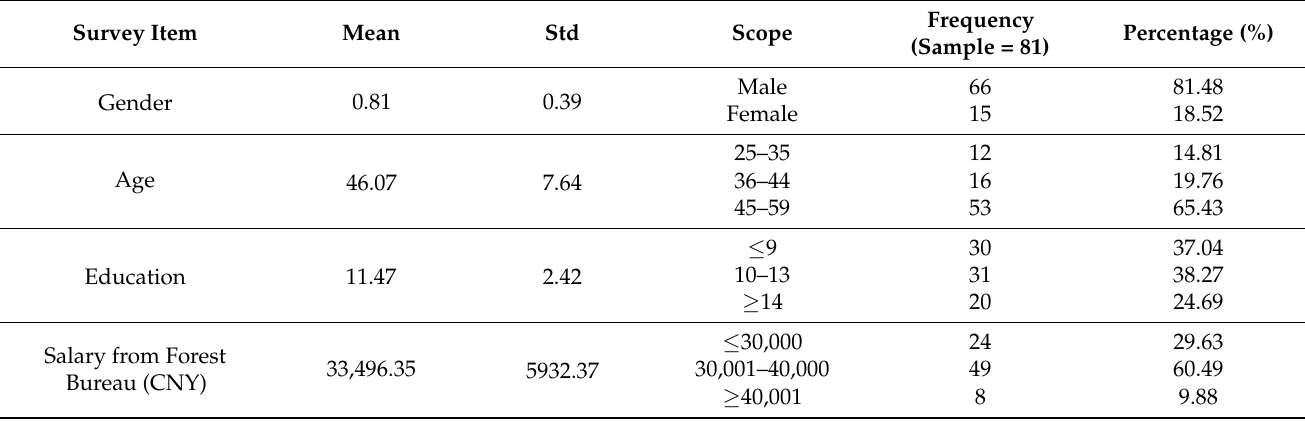
Table 4. Characteristics of sample workers engaged in ecological